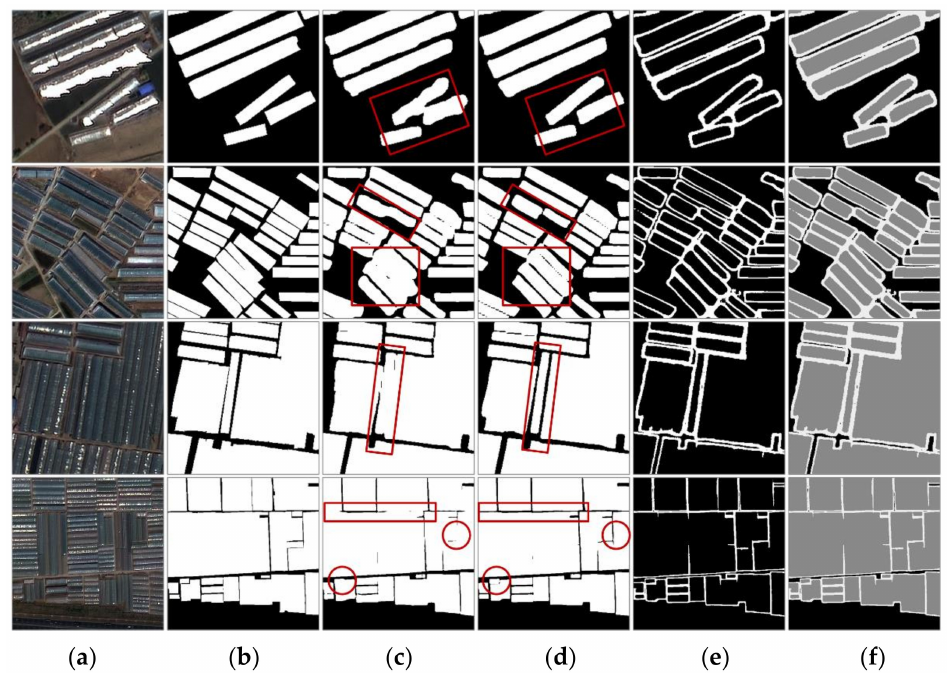
Figure 15. Examples of AG identification results differ whether the BR module participates in training. From left to right: ( a ) Original image. ( b ) Ground truth. ( c ) Prediction by only segmentation task. ( d ) Prediction by the joint of segmentation task and boundary learning ( λ i = 2). ( e ) Boundary prediction; ( f ) Combination of two